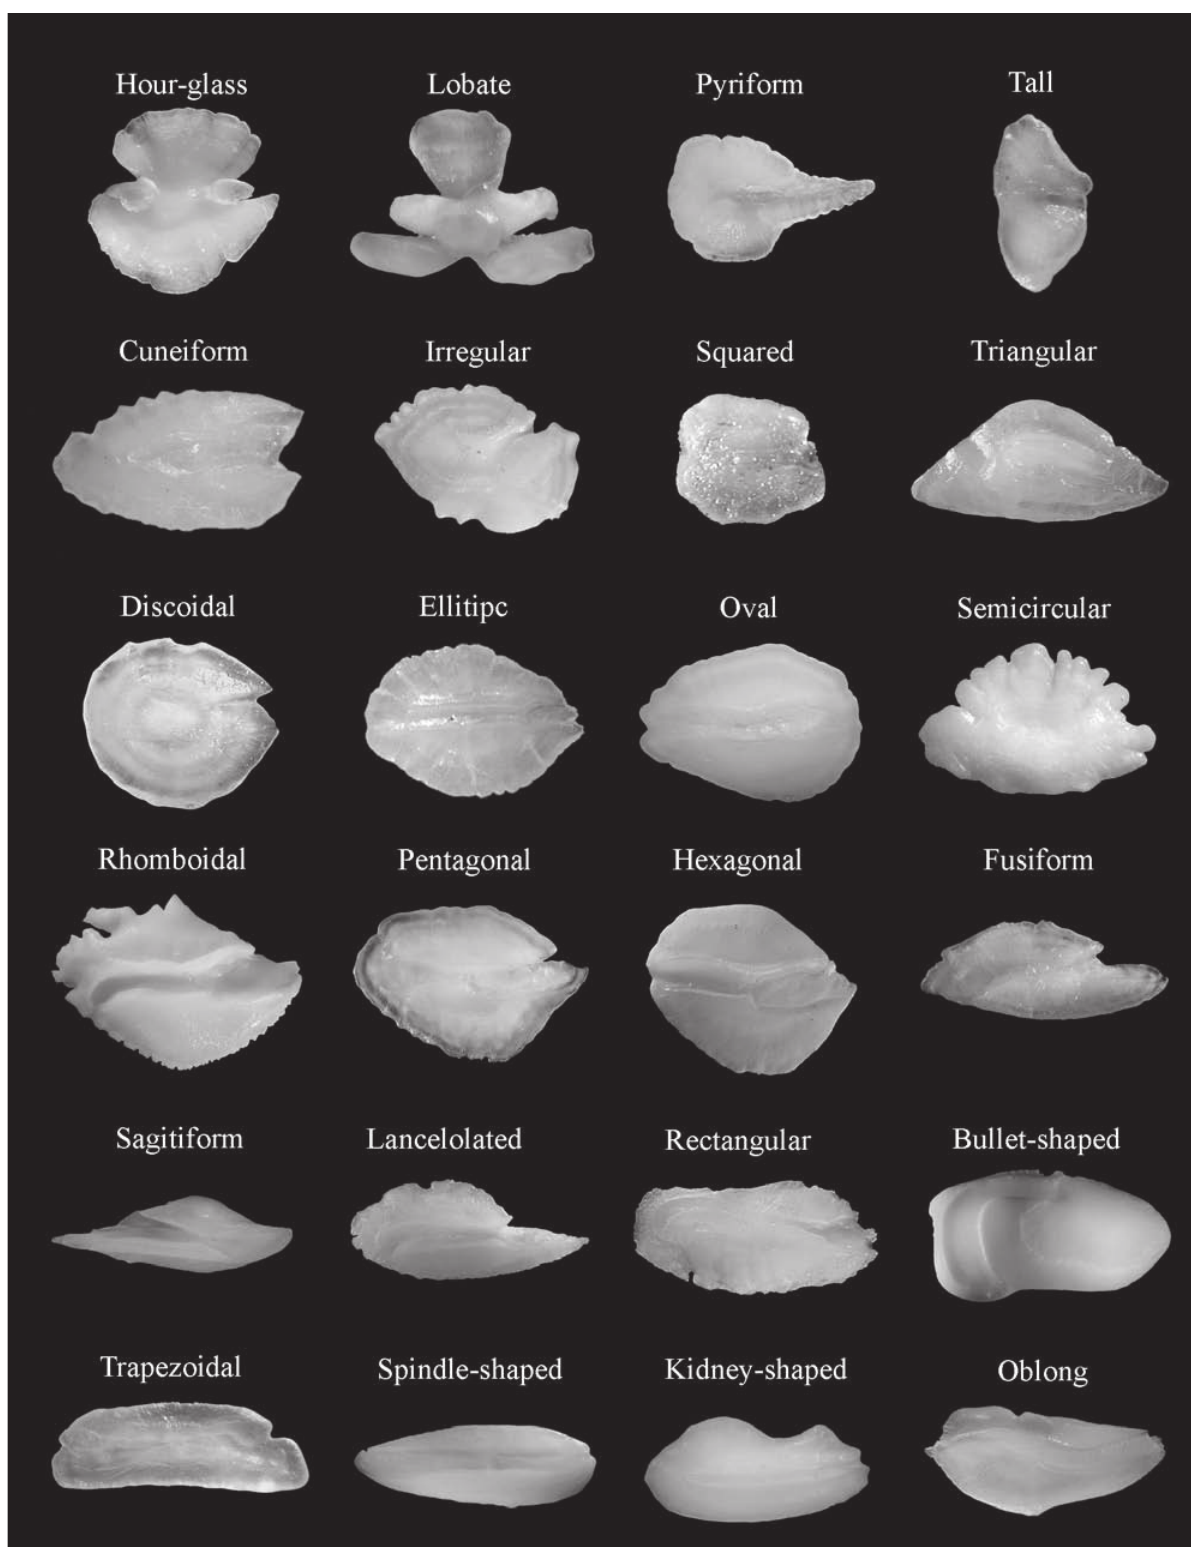
Fig. 4. – Terms used to describe the shapes of the otolith’s